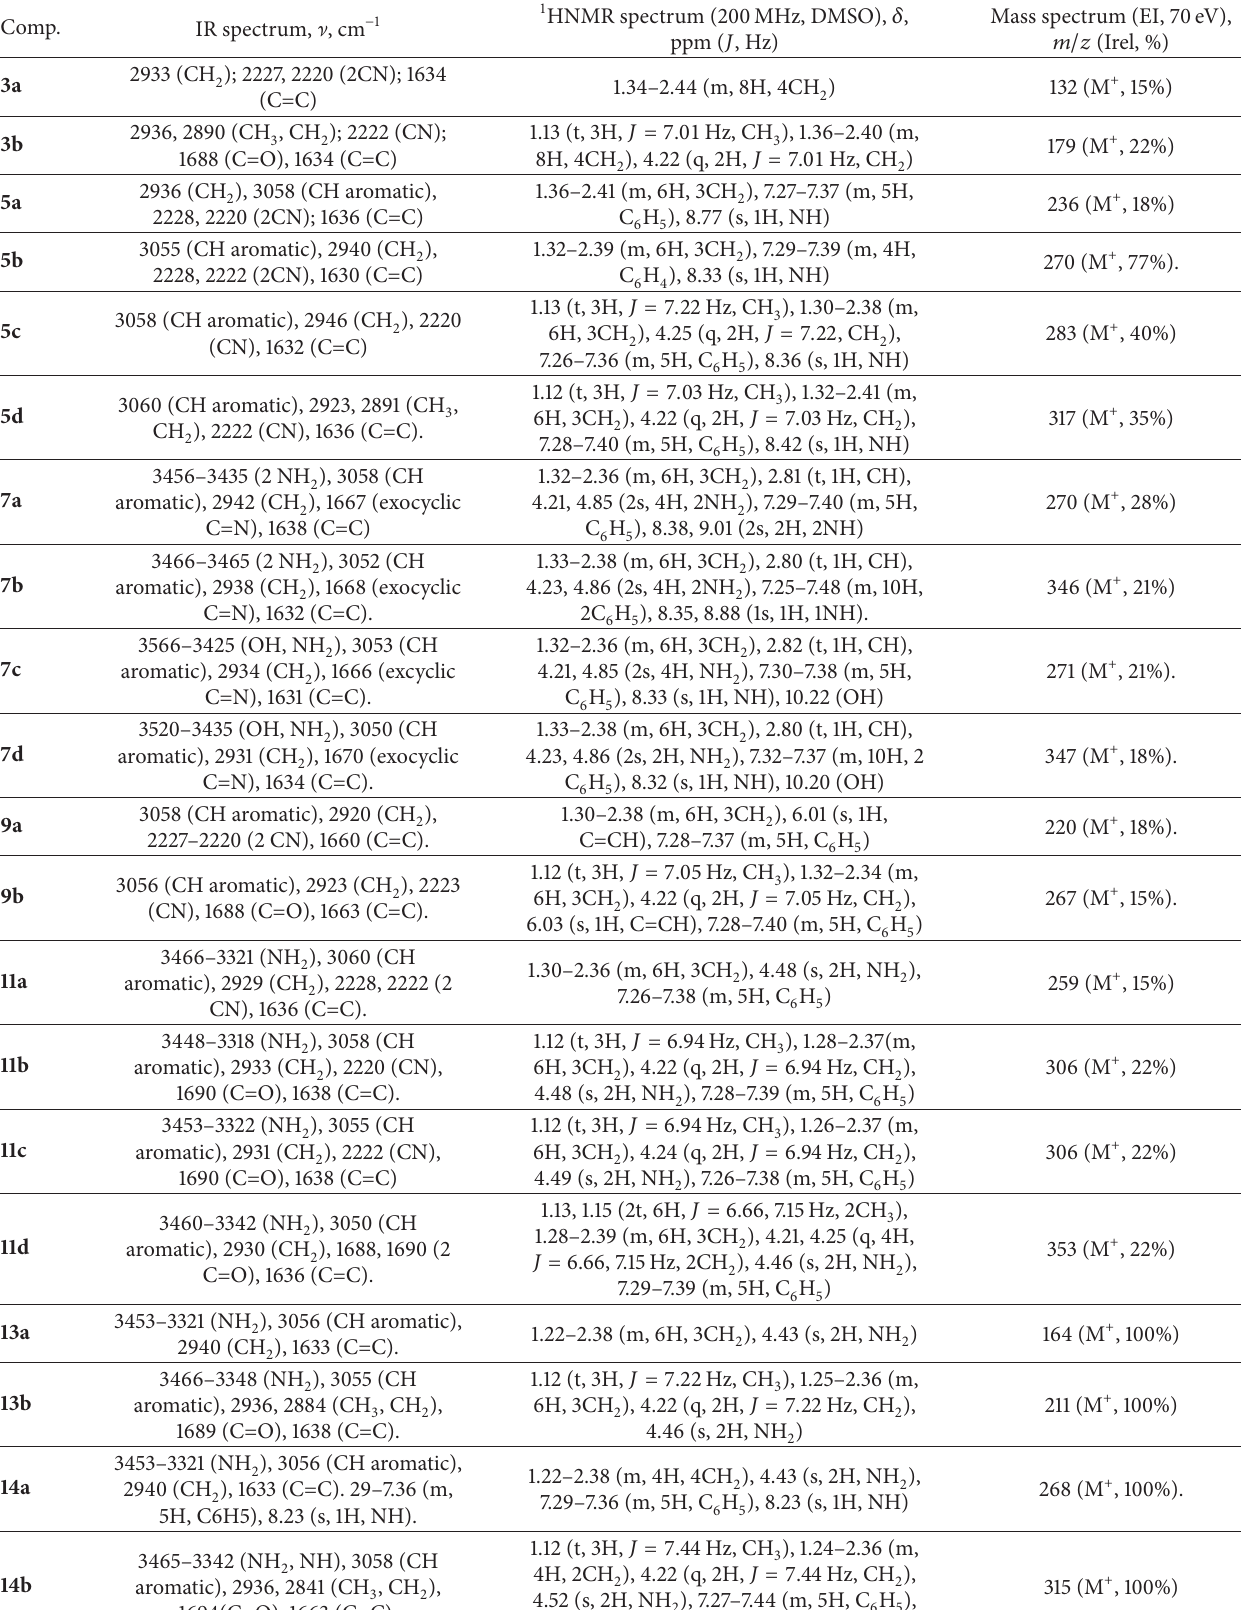
Table 2: Spectral data of the newly synthesized